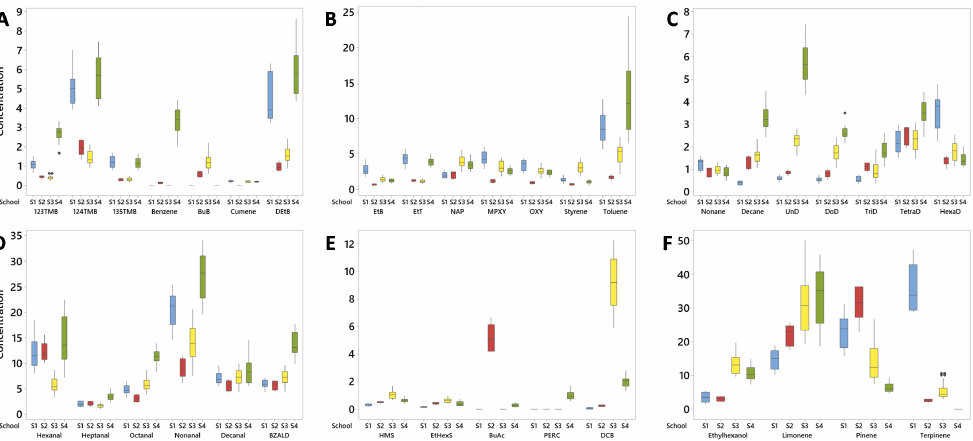
Figure 1. Box plots presenting indoor concentrations ( μ g/m 3 ) of VOCs in the primary schools. ( A , B ) aromatic hydrocarbons, ( C ) alkanes, ( D ) aldehydes, ( E ) esters and chlorinated hydrocarbons, and ( F ) 2-ethylhexanol and terpenes.